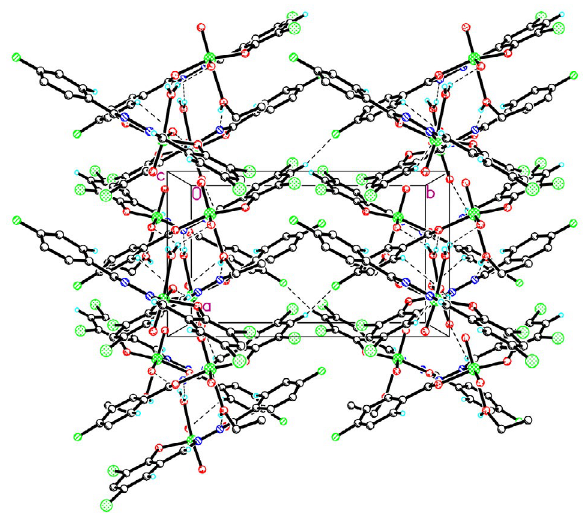
Fig. 4. Molecular packing structure of complex 2 , with hydrogen bonds shown as dotted lines.